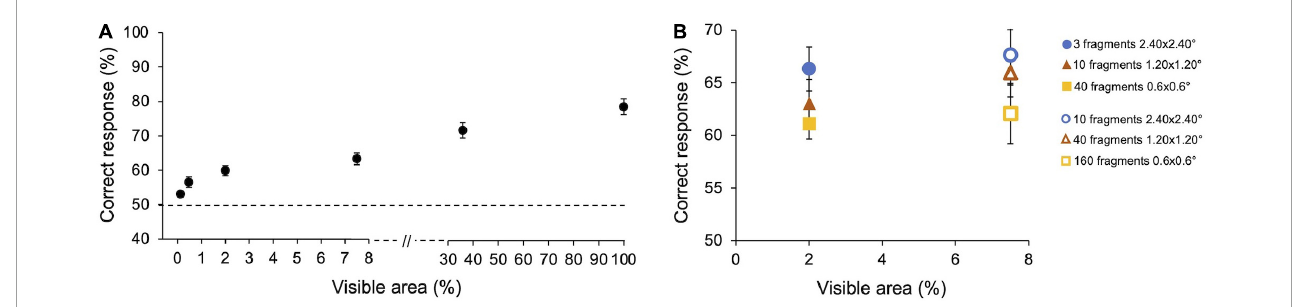
FIGURE3 Preliminary experiments–Results. (A) Performance as a function of images’ visible area. Performance averaged across participants ( n = 10) with SE. Observers performed 3,000 trials in total (300 trials for 100% area and frame conditions and 600 trials for each other areas condition). (B) Performance as a function of the number and size of image fragments. Performance averaged across participants ( n = 5) with SE. Two image areas have been tested: Filled symbols indicate fragments revealing 2% of the area; empty symbols indicate fragments revealing 7.5% of the area. Symbols with the same shape indicate a different number of fragments of the same size. Observers performed 3,600 trials in total (600 trials for each condition).